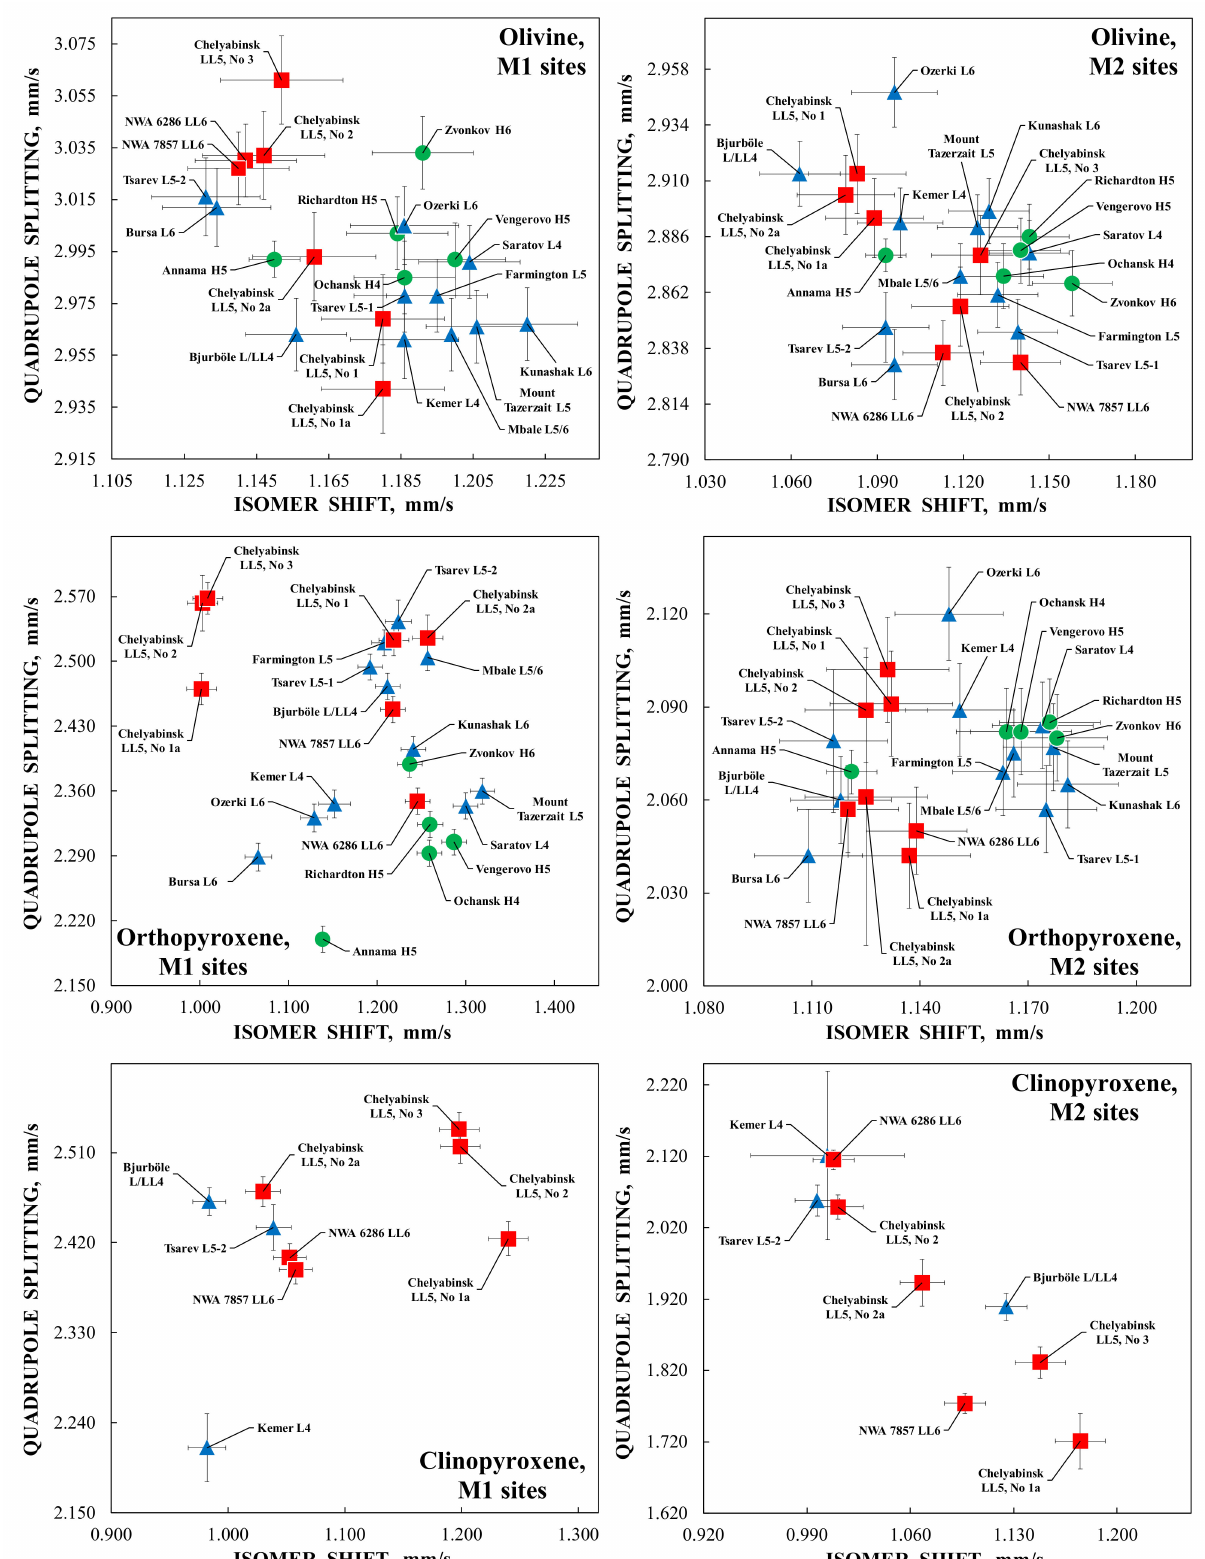
Figure 41. Comparison of the 57 Fe hyperfine parameters for the M1 and M2 sites in olivine, orthopyroxene and clinopyroxene in ordinary chondrites from the H, L, and LL groups obtained by Mössbauer spectroscopy with a high velocity resolution. —H ordinary chondrites, —L ordinary chondrites, —LL ordinary chondrites. Data were taken for indicated meteorites in the corresponding references mentioned in Sections